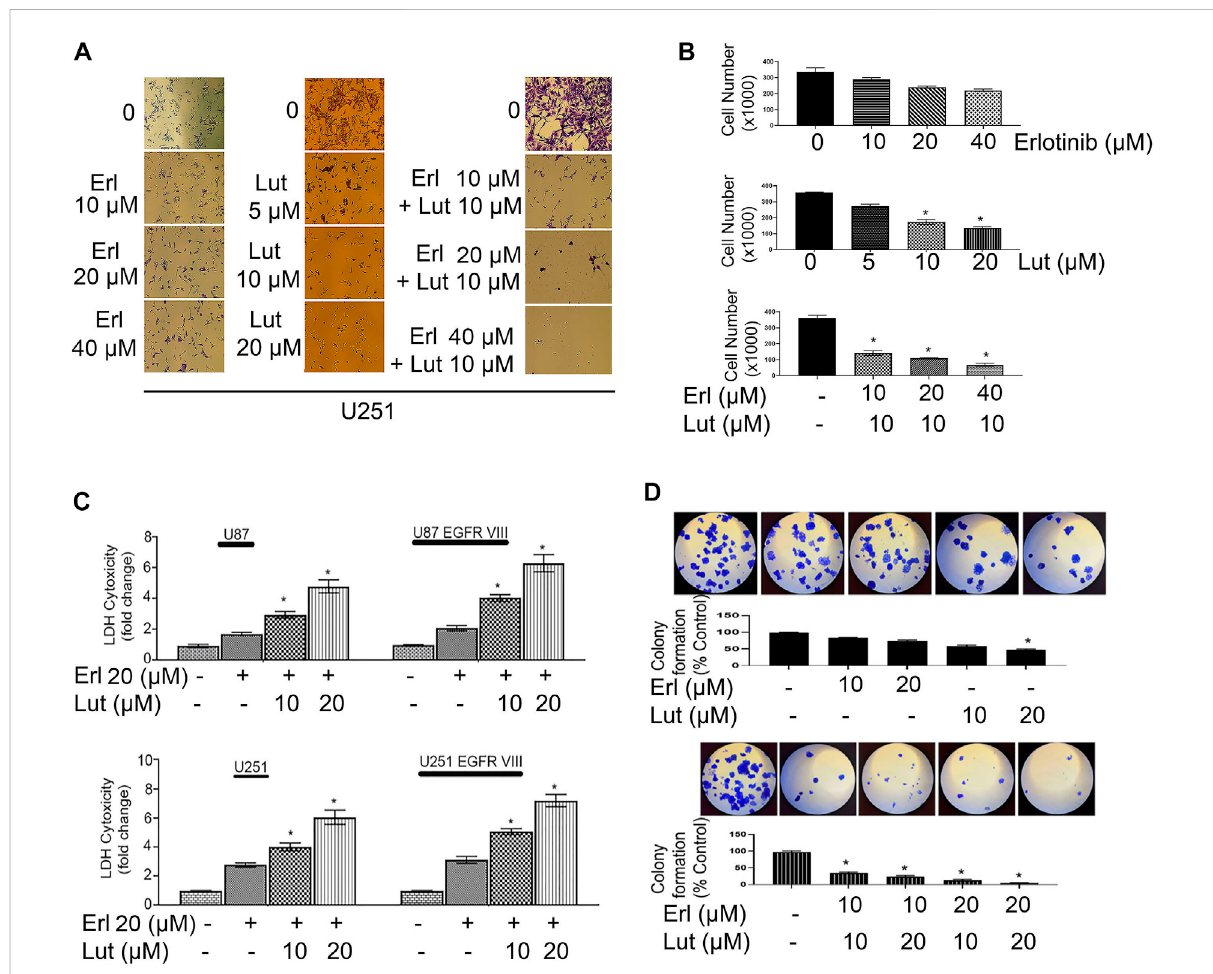
FIGURE 3 Effects of erlotinib and luteolin on cell morphology, cell counts, LDH assay, and colony formation assay. (A) The effects of erlotinib (0 – 40 µM) andluteolin (0 – 20 µM)on cellmorphology.Thecombined effectsoferlotinib (10 – 40 µM)andluteolin 10 µMoncell morphology. (B) Thebargraph represents the number of viable cells following treatment with erlotinib or luteolin alone and the combination of both compounds. * p < 0.05 versus control. (C) The effects of erlotinib (20 µM) and luteolin (10 µM) on LDH release. The combined treatment showed a signi fi cant (* p < 0.05) increase in LDH release in glioblastoma cell lines. (D) The effects of erlotinib (10 – 20 µM) and luteolin (10 – 20 µM) alone on colony formation assay (upper panel). The combined treatment showed a signi fi cant decrease in the number of colonies formed in the U251 glioblastoma cell line (lower